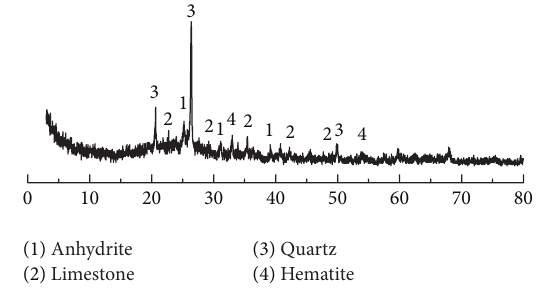
Figure 1: XRD patterns of CFB ash. Table 2: Chemical compositions of raw